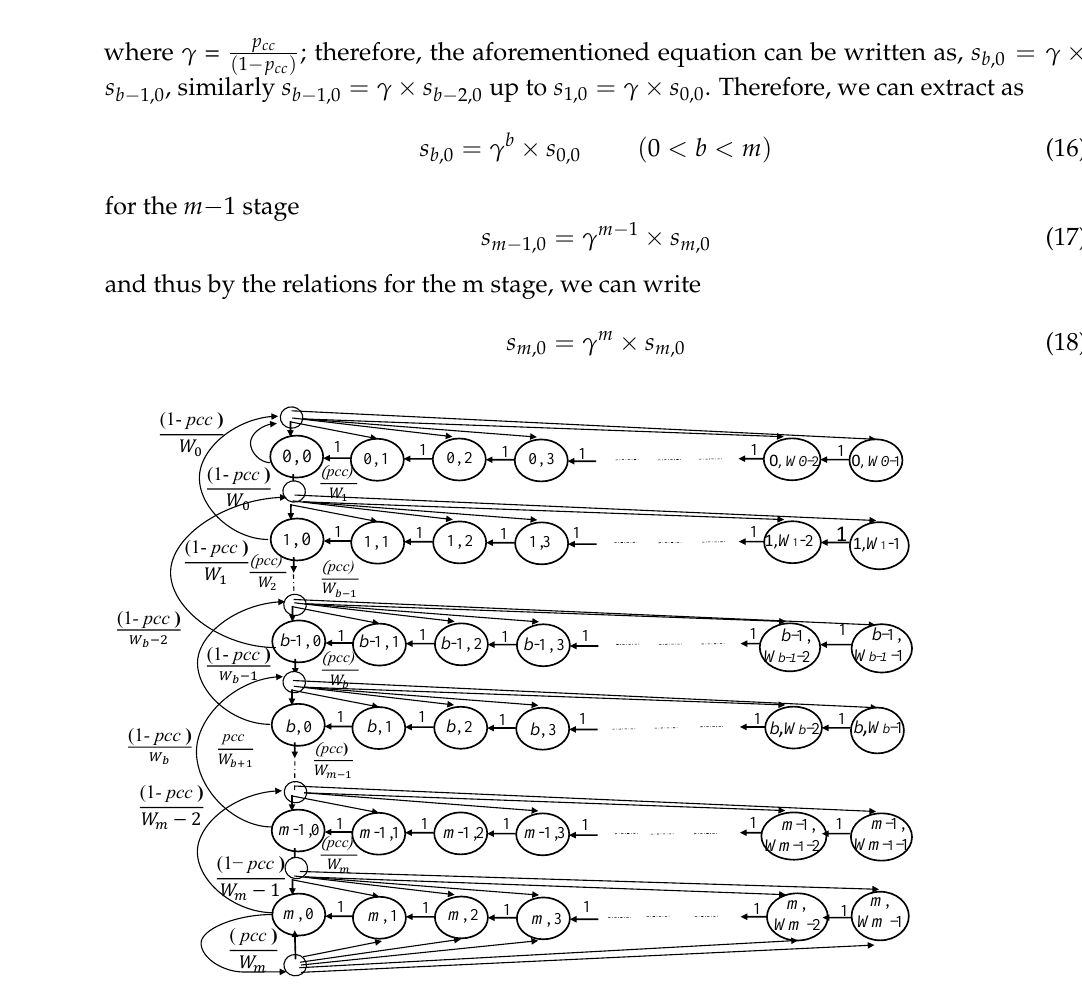
Figure 6. Iterative discrete time Markov chain (I-DTMC) model for the channel collision-based window-scaled back-off (CWSB)